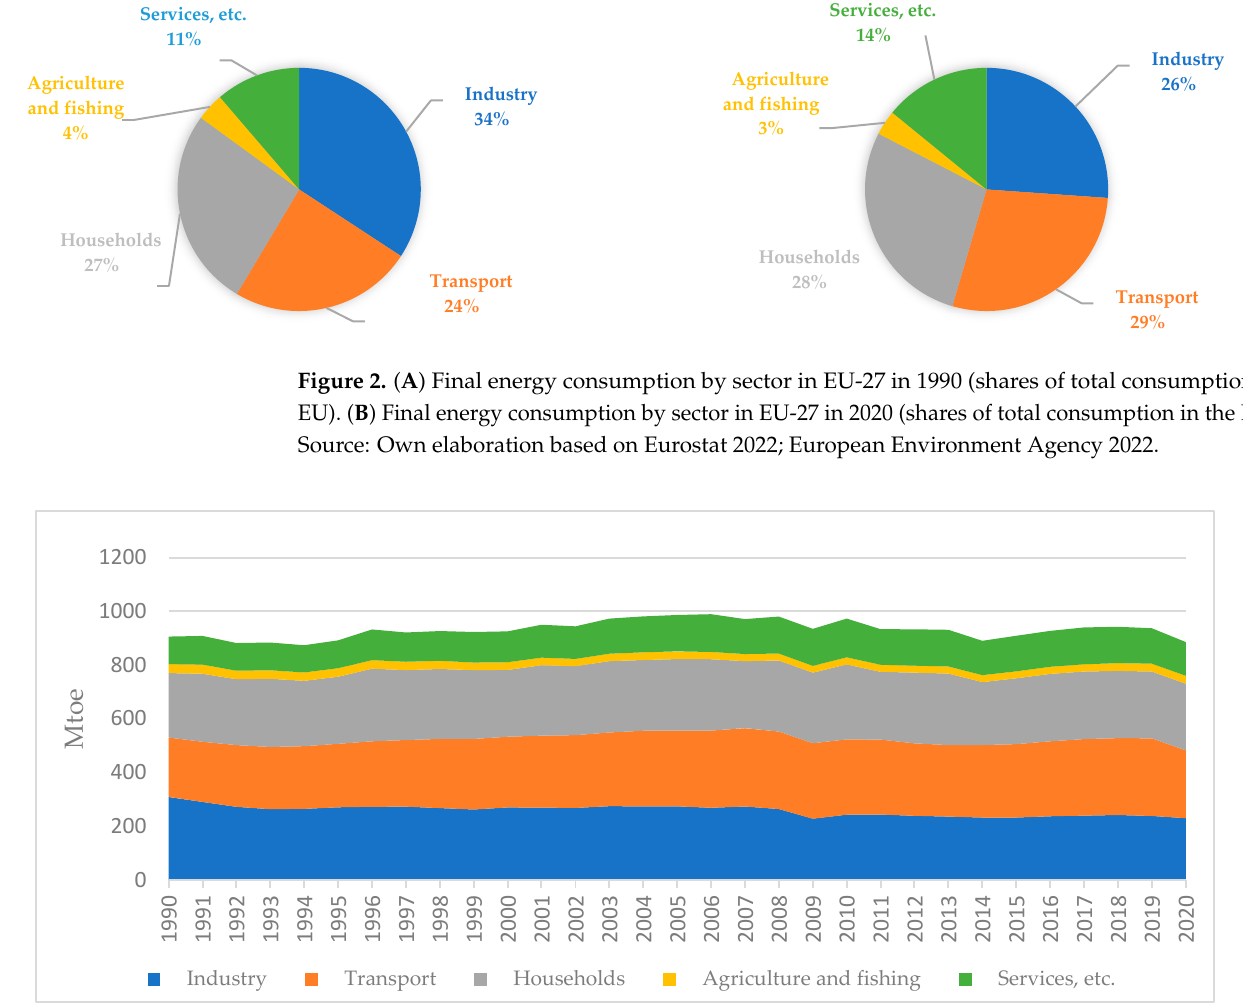
Figure 3. Final energy consumption by sector in EU-27 in the years 1990–2020 (Mtoe). Source: Own elaboration based on Eurostat 2022; European Environment Agency 2022.